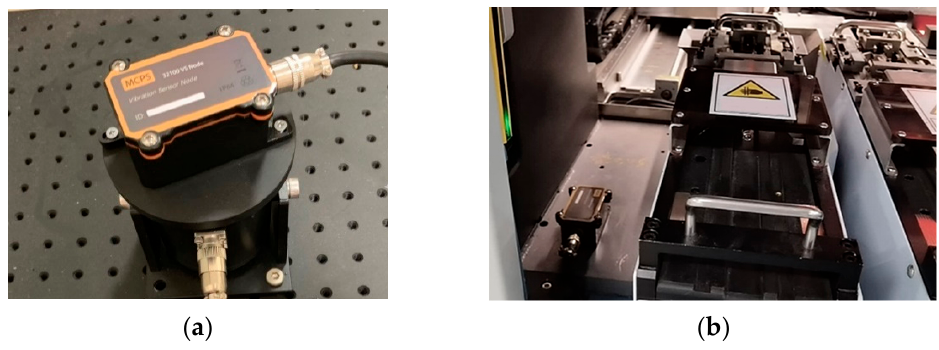
Figure 6. ( a ) Sensor node; ( b ) the IIoT sensor node installed in the component insertion machine.